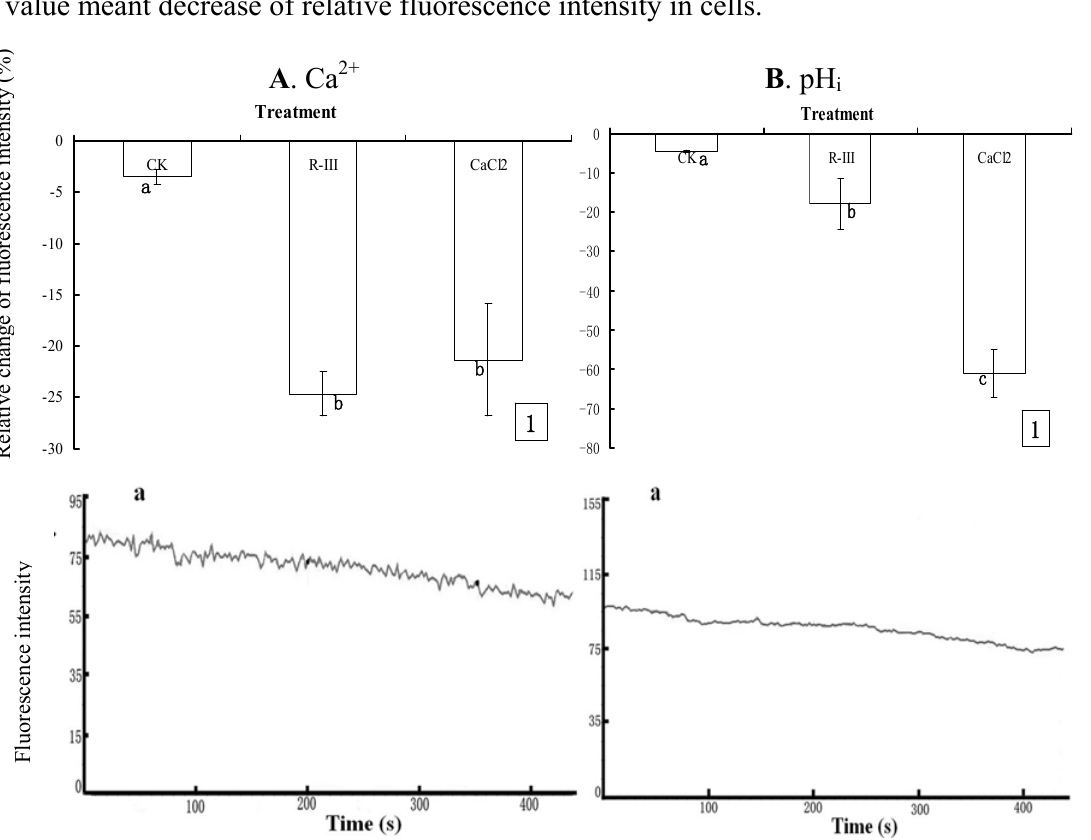
Figure 5. Effects of R-III on [Ca 2+ ] and pH in Sf9 cells in presence of Dhanks. i i ( A1 ). Changes of [Ca 2+ ] when cells were stimulated by 100 μ g/mL in 130 s and i in 500 s, as indicated by relative change of Fluo-3AM subsequent addition of 2 μ M CaCl 2 fluorescence intensity; ( A-a ). Control; ( A-b ). Dynamic changes of [Ca 2+ ] in the same i conditions with (A1) ; ( B ). pH profile in cells subjected to the protocol in ( A ). Results of i representative experiment derived from three repetitions and 4–6 cells were measured in each repetition. The error bars represent mean ± SEM for data derived from value of relative fluorescence intensity ( vs. control) in each time interval. Treatment means sharing the same letter were not significantly different from each other ( P < 0 . 05). The negative value meant decrease of relative fluorescence intensity in